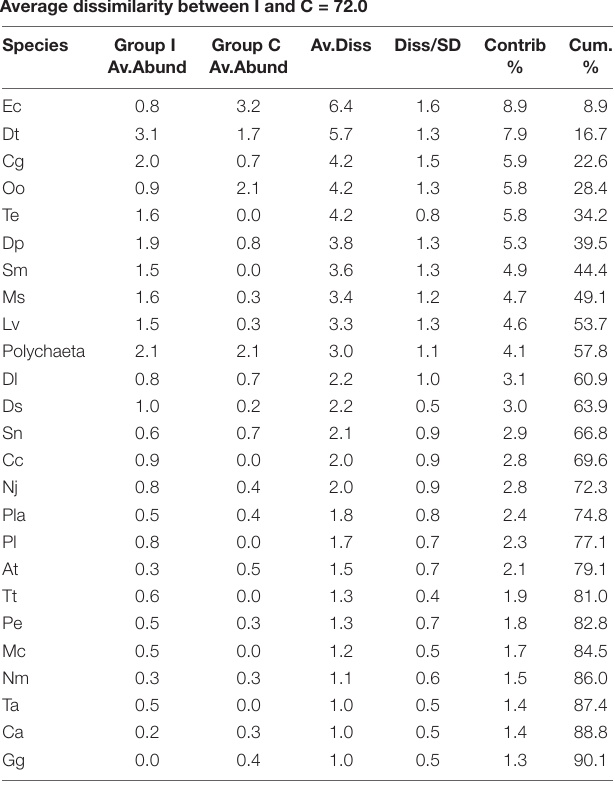
Average dissimilarity between I and C = 72.0